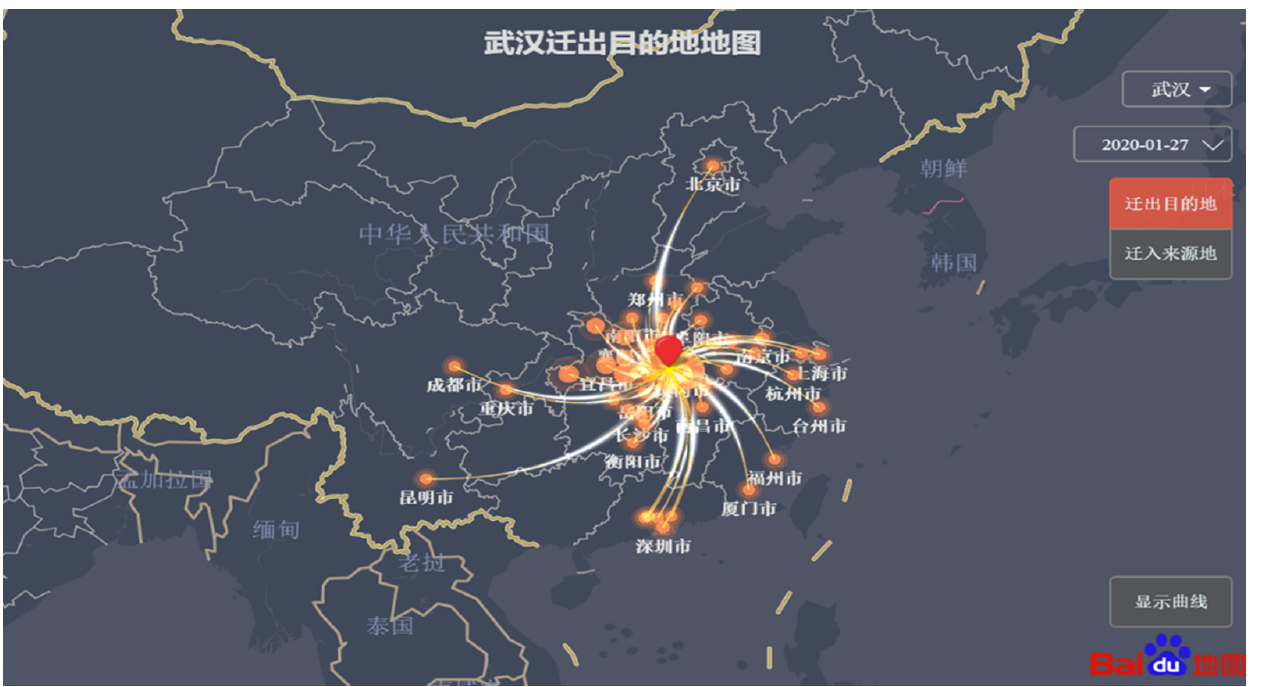
Figure 19. A screenshot of real-time Wuhan’ residents emigration destination of Baidu map. [245].